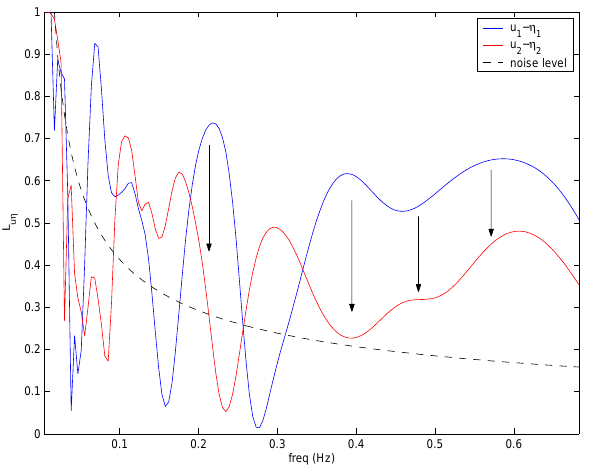
Fig. 10. Wavelet linear coherence between the wave and the wind fluctuations in stages I and II; arrows highlight the changes of the coherence level at major frequency components.